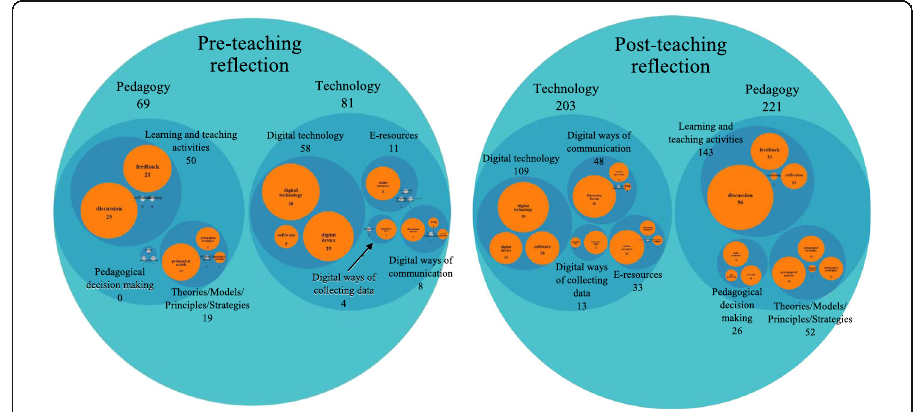
Fig. 3 Hierarchical visualization of the results on computer-aided analysis of learners ’ pre-teaching